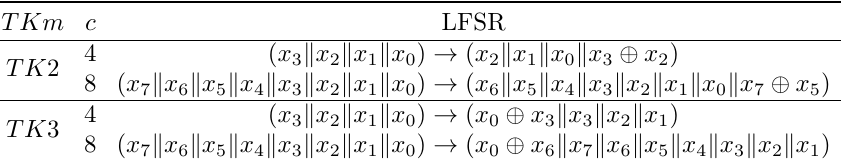
Table 15: The LFSRs used in the tweakey schedule of SKINNY